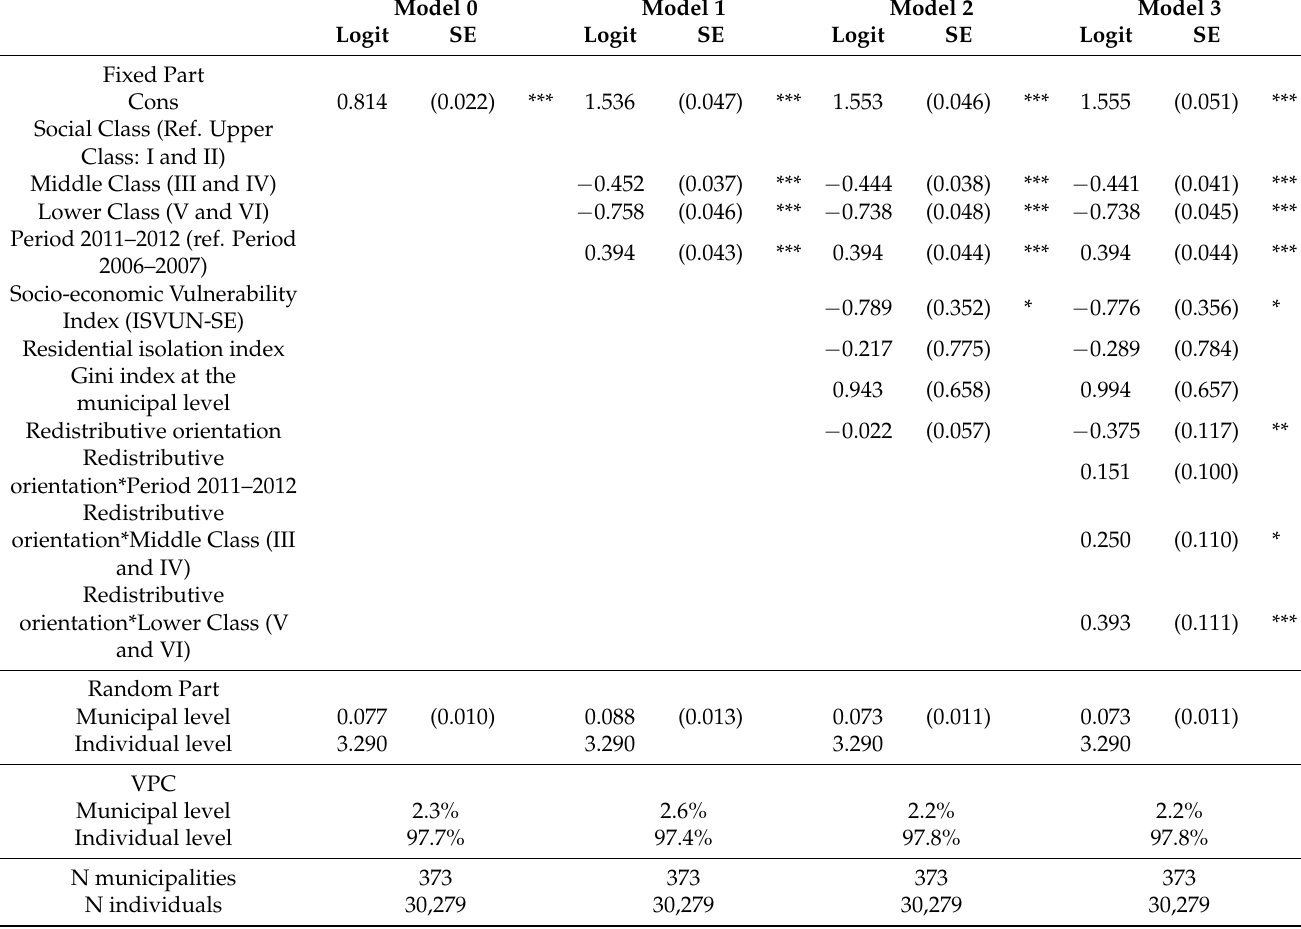
Table 2. Multilevel models for self-perceived good